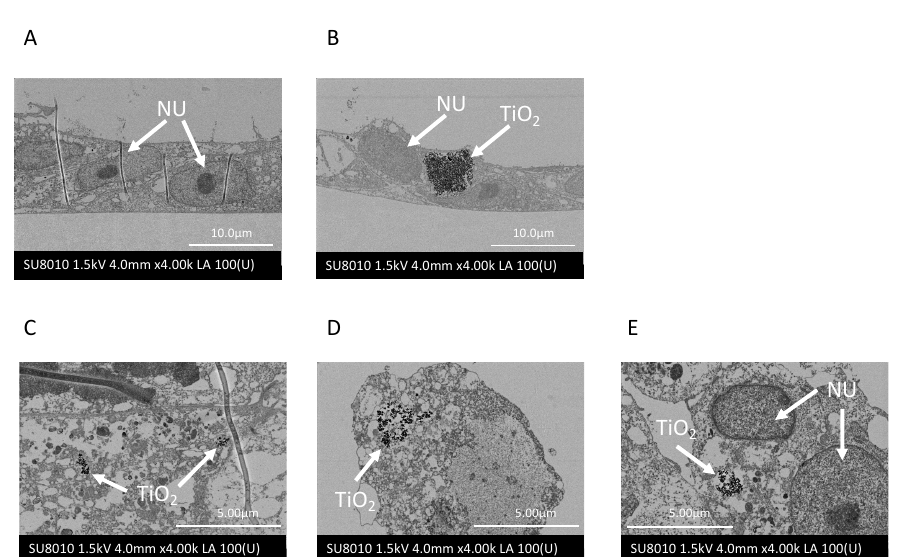
Figure 2. Scanning electron microscopy (SEM) images of Ca9-22 cells. ( A ) Control, ( B ) incubation with 100 µg/mL nanotitania for 1 h, ( C ) incubation with 10 µg/mL nanotitania for 1 h, ( D ) incubation with 10 µg/mL nanotitania for 12 h, ( E ) incubation with 10 µg/mL nanotitania for 24 h. NU, nuclear; TiO 2 , nanotitania.